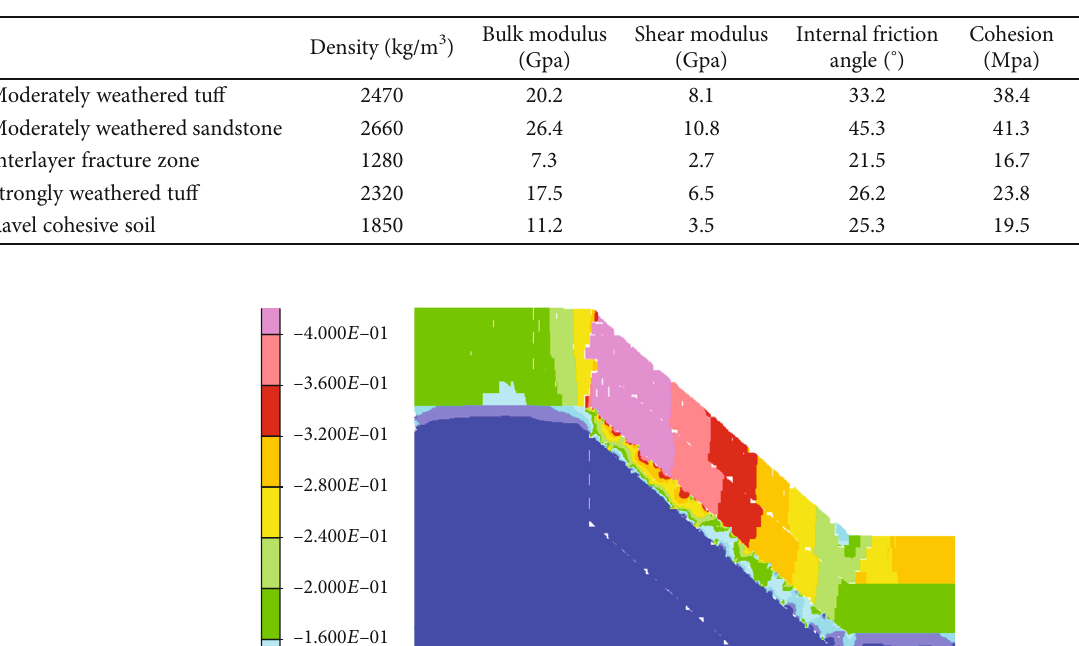
Table 2: Basic mechanical characteristic parameters of materials.